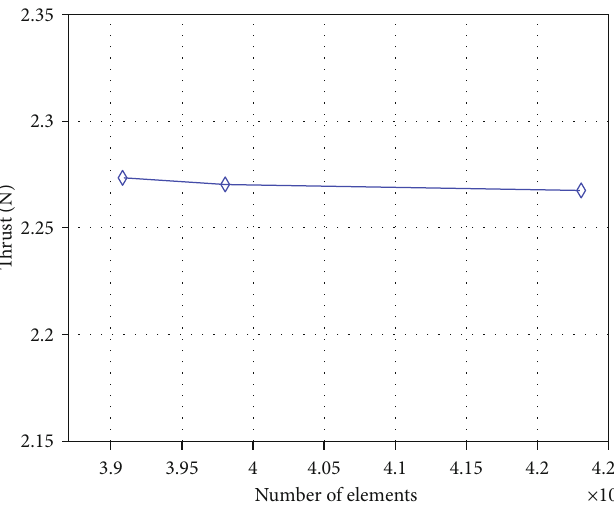
Figure 14: Mesh independence.